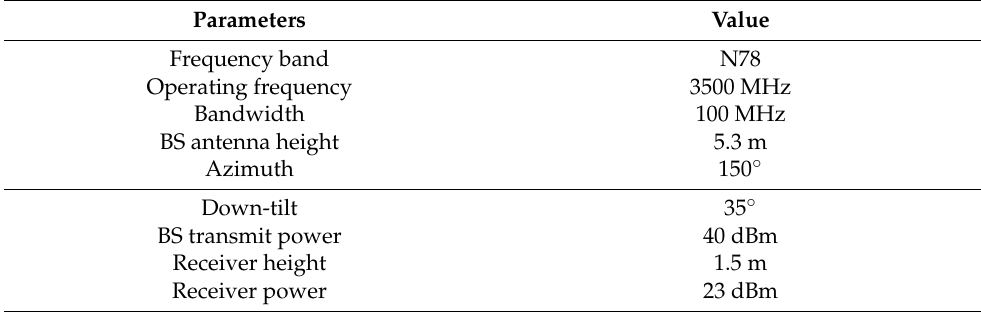
Table 4. 5G parameters for radio simulation.